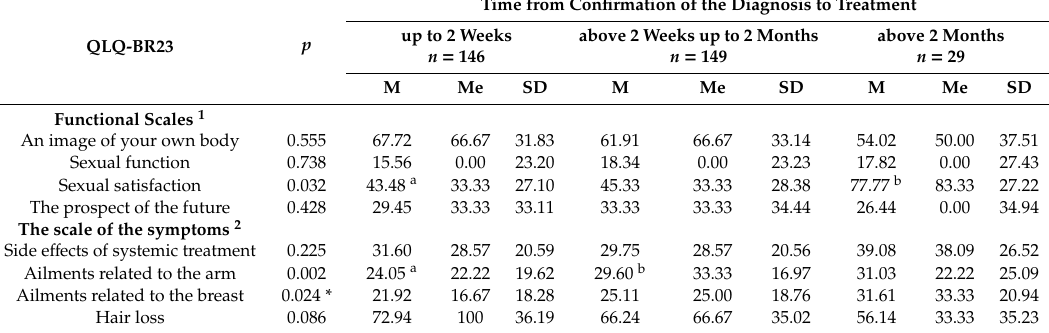
Table 8. Assessment of women’s quality of life—categories related to QLQ-BR23 and the time from diagnosis confirmation to